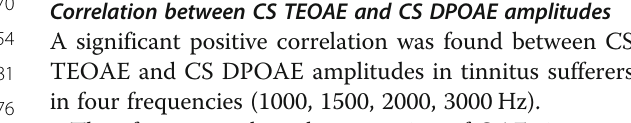
Table 7 Correlation between TEOAE and DPOAE (f2) amplitudes in the patient group ( n = 15, ears = 30) TEOAE 1000 vs. DPOAE 1001(f2) amplitude − 0.031 0.869 TEOAE 1500 vs. DPOAE 1587(f2) amplitude 0.335 0.070 TEOAE 2000 vs. DPOAE 2002(f2) amplitude 0.267 TEOAE 3000 vs. DPOAE 3174(f2) amplitude TEOAE 4000 vs. DPOAE 4004(f2) amplitude 0.254